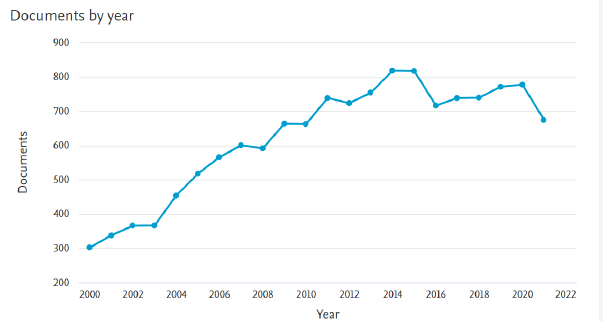
Figure 4. Trends of the QCM